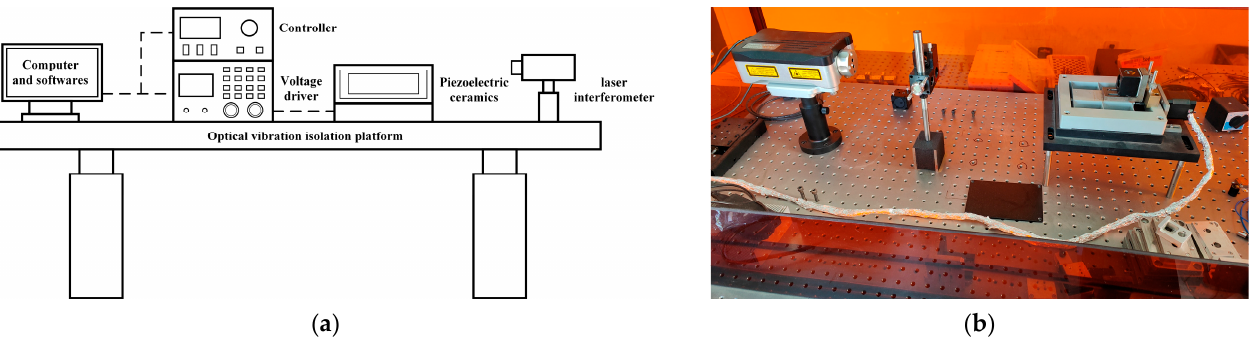
Figure 2. Nano platform experimental system: ( a ) system schematic diagram; ( b ) system build diagram.